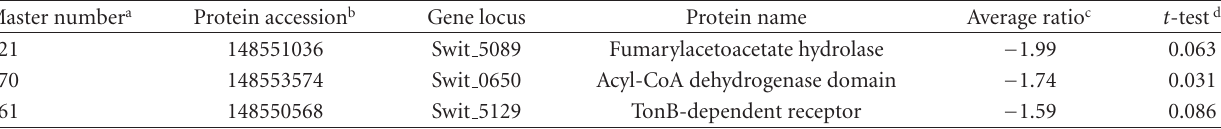
Table 2: Proteins identified as decreased in S. wittichii RW1 during growth on dibenzofuran as compared to acetate. The spots were identified on a minimum of 6 gel images.